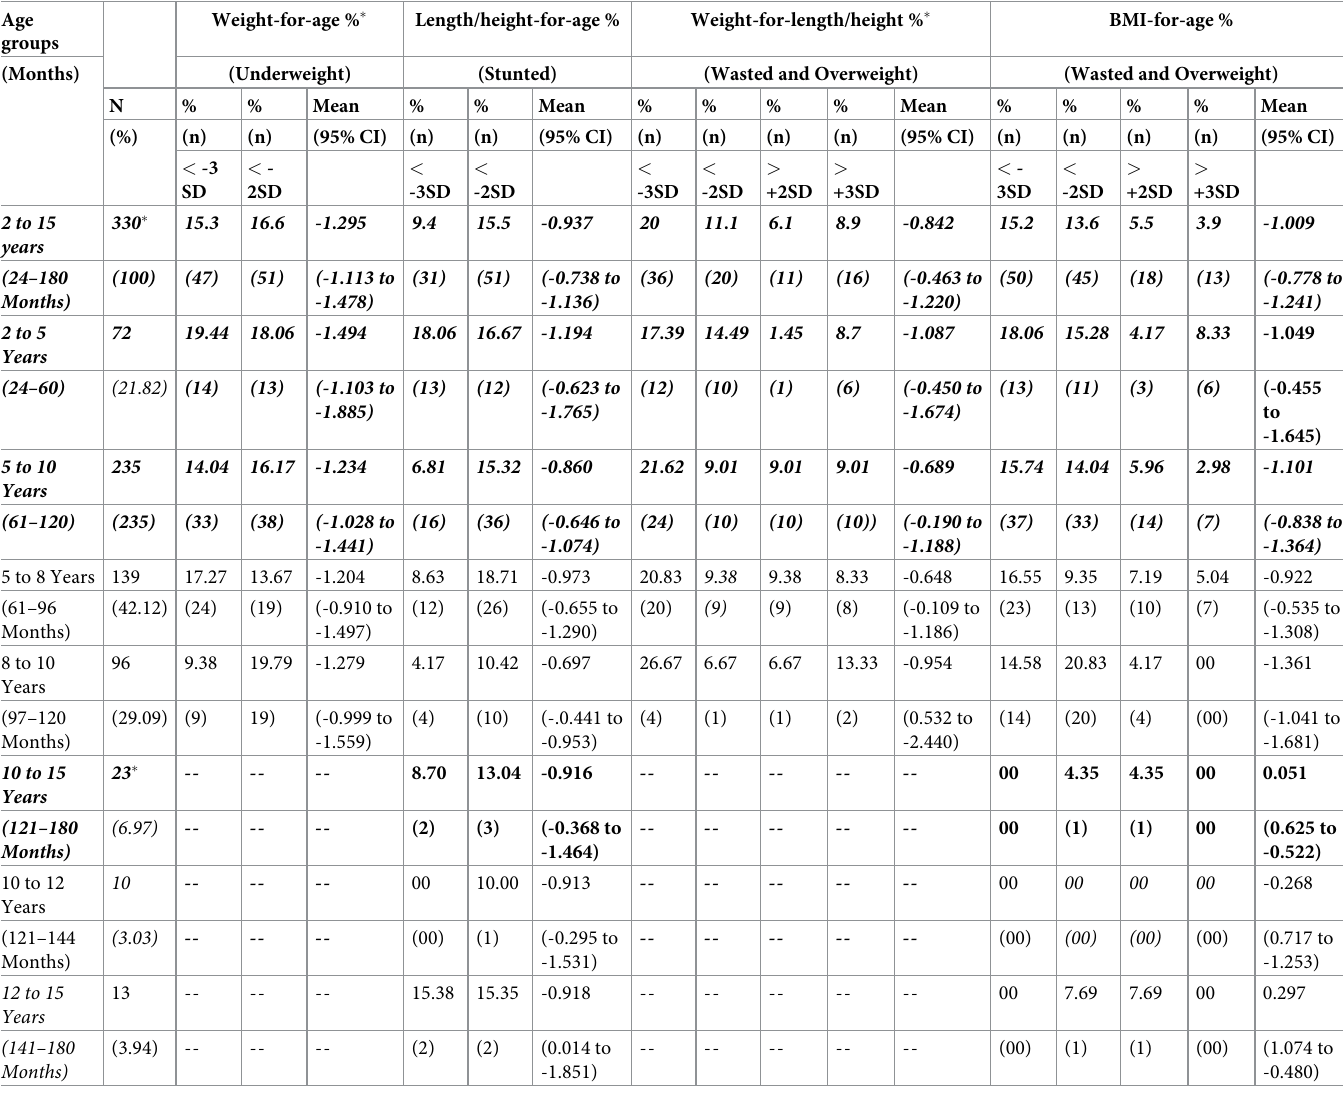
Table 4. Percentage of children aged 2–15 years classified as malnourished according to anthropometric indices of nutritional status: Height-for-age, weight-for- height, weight-for-age and